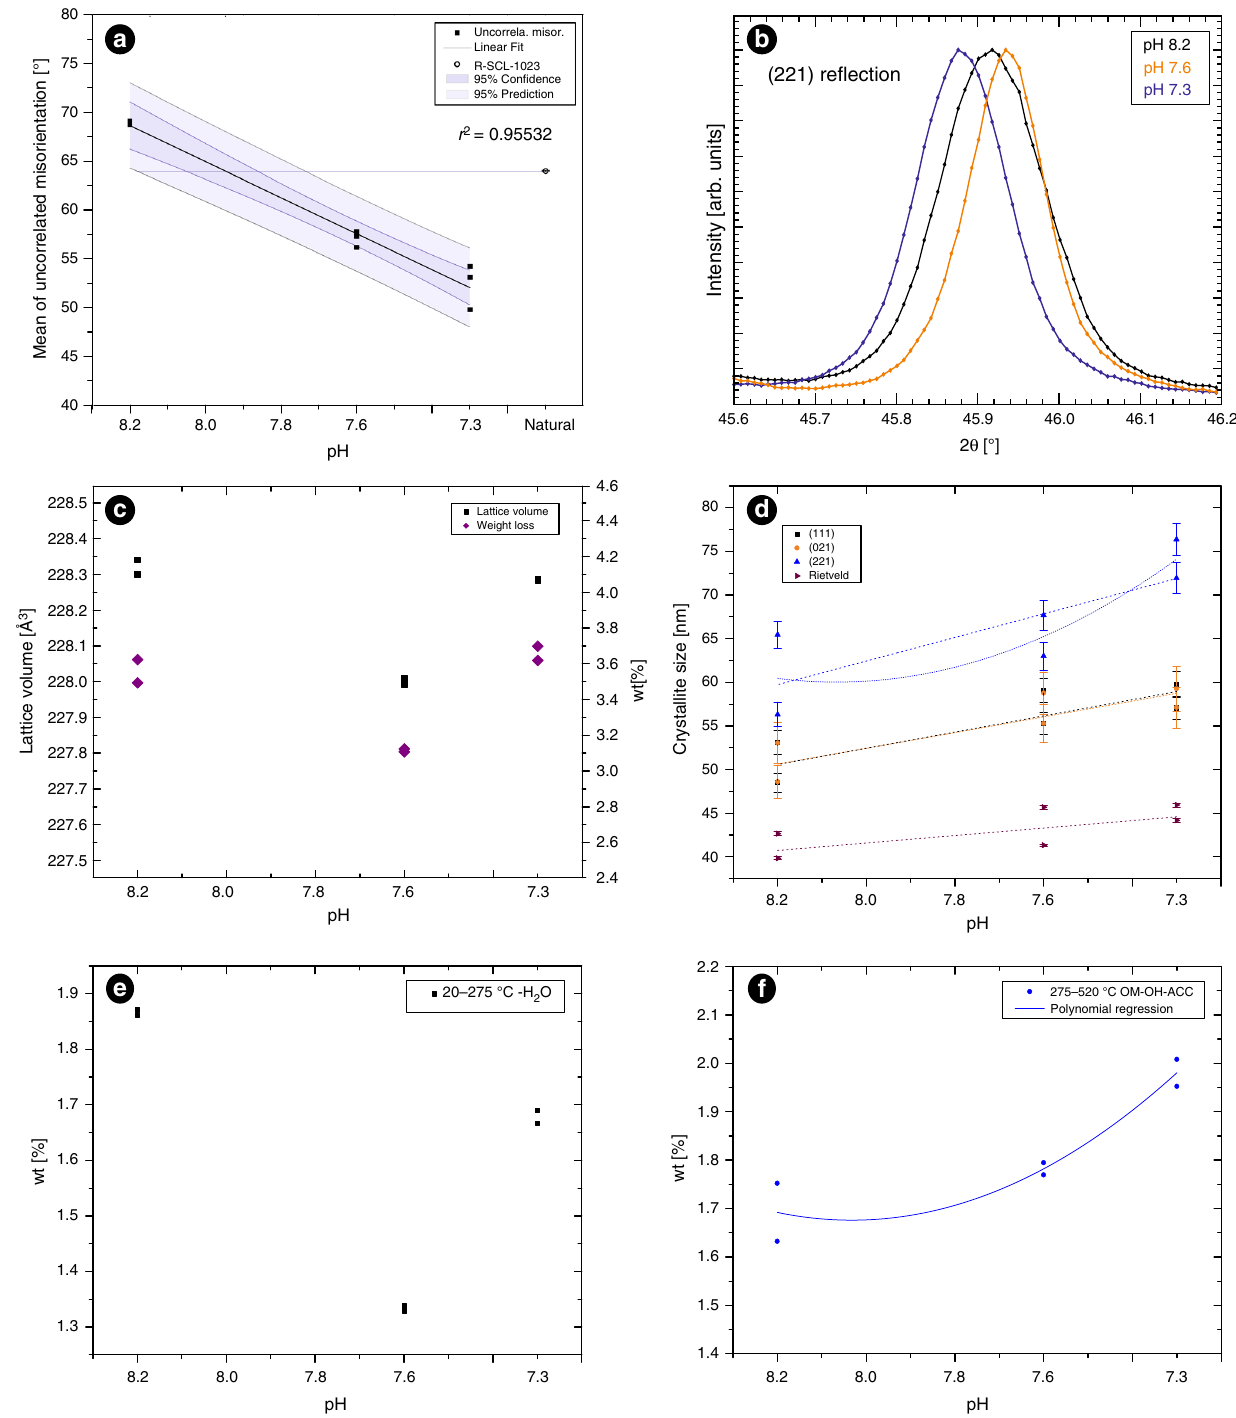
Fig. 2 Crystallographic changes in the skeleton of Stylophora pistillata cultured at different pH conditions. a Mean of uncorrelated misorientation versus pH and an external natural sample (R-SCL-1023) as a control point. The black line is the linear regression of samples cultured at different pH conditions. The decreasing response to acidi fi cation in the mean of uncorrelated misorientation indicates that the crystallographic control exerted by coral at microscale increases at low pH. b Comparison between angular positions of a selected diffraction peak taken, belonging to (221) re fl ection. Note the shift in the angular position between pH 8.2 on regard to 7.6 samples to higher angles and 7.3 to lower angles. c Lattice volume calculated for each pH (black squares) and the total weight % loss (purple diamonds) in the range 20 – 520 °C. d Calculations of crystallite size for the skeletons of the 3 different pH treatments. Note the increment of all of them, independently of the method. The error bars represent calculated error of crystal size after re fi nement of UVW- parameters. Plane (221) is showing a larger crystallite size. Curved blue line corresponds with polynomial regression, whereas straight lines correspond with linear regression. e Water regime (20 – 275 °C). f OM-OH-ACC regime (275 – 520°C). Blue line correspond with the polynomial regression of the points ( r 2 = 0.843). OM organic matrix, OH OH groups, ACC possible Amorphous Calcium